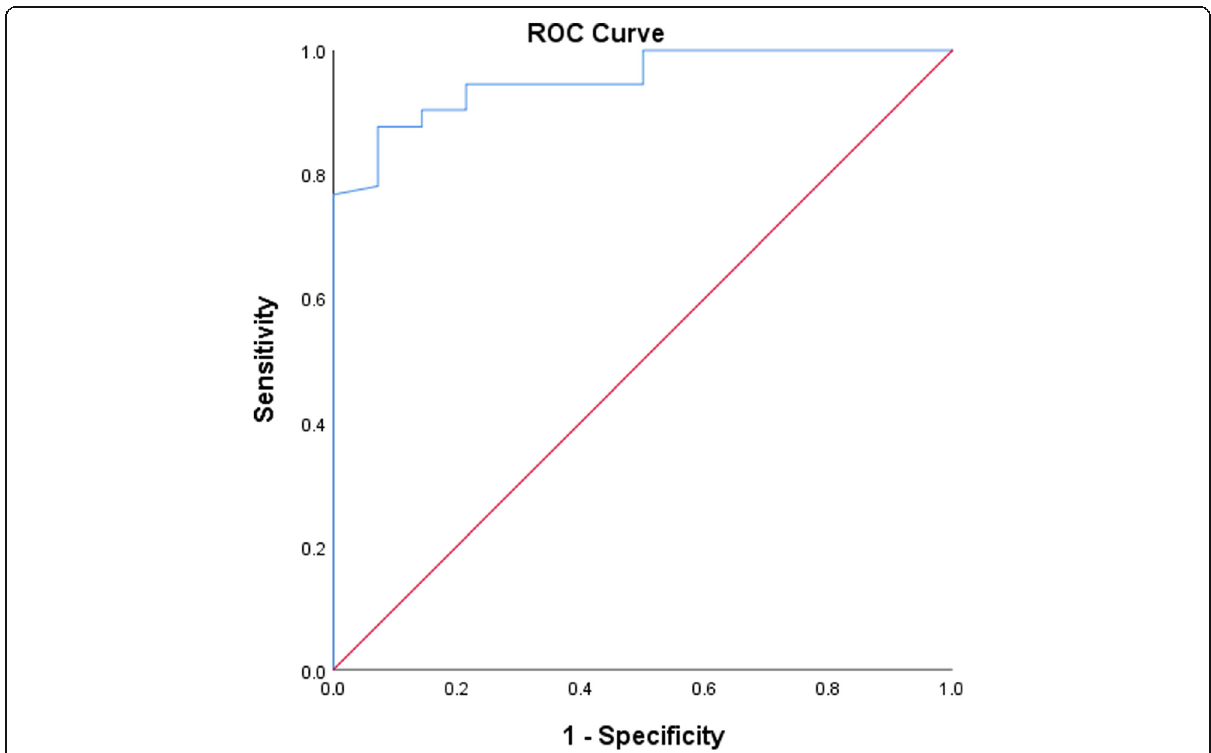
Fig. 4 The ROC curve of the combined predictor of patient satisfaction. The new predictor combined the postoperative KSS with the angle E, and the area under the ROC curve was